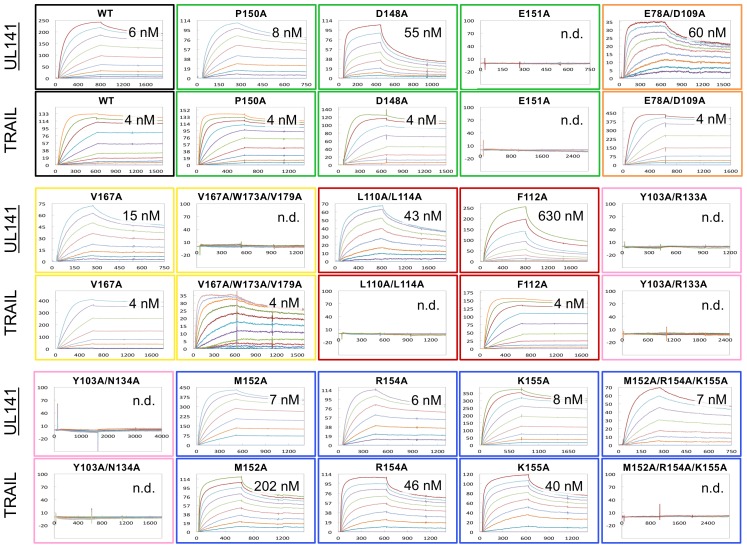
Binding of TRAIL-R2 mutants to TRAIL and UL141.Surface plasmon resonance study to assess the binding contribution of individual TRAIL-R2 residues to both viral UL141 and endogenous TRAIL. A Sensorgram for each kinetics experiment is shown in colored boxes (colored by binding patch as in Figure 4). The specific alanine mutation on TRAIL-R2 as well as the calculated binding constant KD (nM) are indicated for each panel. Mutations that fully abrogate binding are indicated as n.d. (binding not detected).